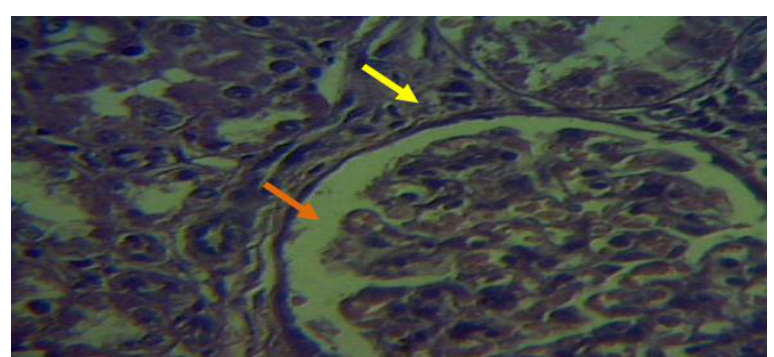
Figure (1):- Histopathological section of liver for rat after 20 days of treatment with OTA at dose 70µg/kg show dilatation of sinusoid with neutrophils in their lumen ( ) as well as necrosis of hepatocyte cells ( ).